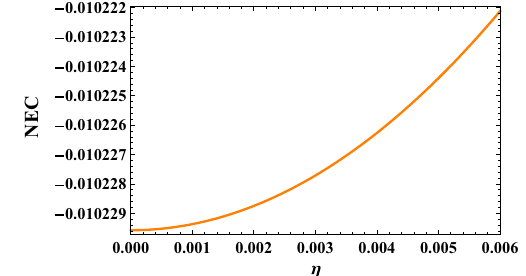
Fig. 12 NEC is shown at the radial distance r = 1 . 5 kpc with respect totheGlobalMonopoleCharge η correspondingtotheparameters ρ 0 = 0 . 004 kpc − 2 , α = 0 . 5 , β = 0 . 8 , r th = 1 kpc , C = 0 . 05 , j = 1 , k = 1 , δ = 0 . 1 , γ = 0 . 001 and r 0 = 2 kpc